Question: Write a descriptive caption for this figure.
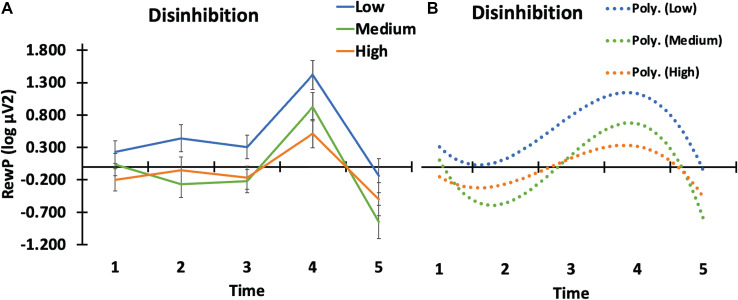
Answer: long description. EEG power of disinhibition group on RewP . Note: The Y axis represents the EEG (log µV 2 ) for the measure of the GAS – reward positivity (RewP). The X axis presents the time points (ms): 1 = 0–70; 2 = 70–100; 3 = 100–200; 4 = 200–300; 5 = 300–400. Disinhibition groups are: low (blue); medium (green; and high (orange). Poly. = polynomial. A = findings for disinhibition group on EEG measure for GAS. B = polynomial trend for each disinhibition group: low (blue); medium (green); and high (orange). Error bars represent standard error.